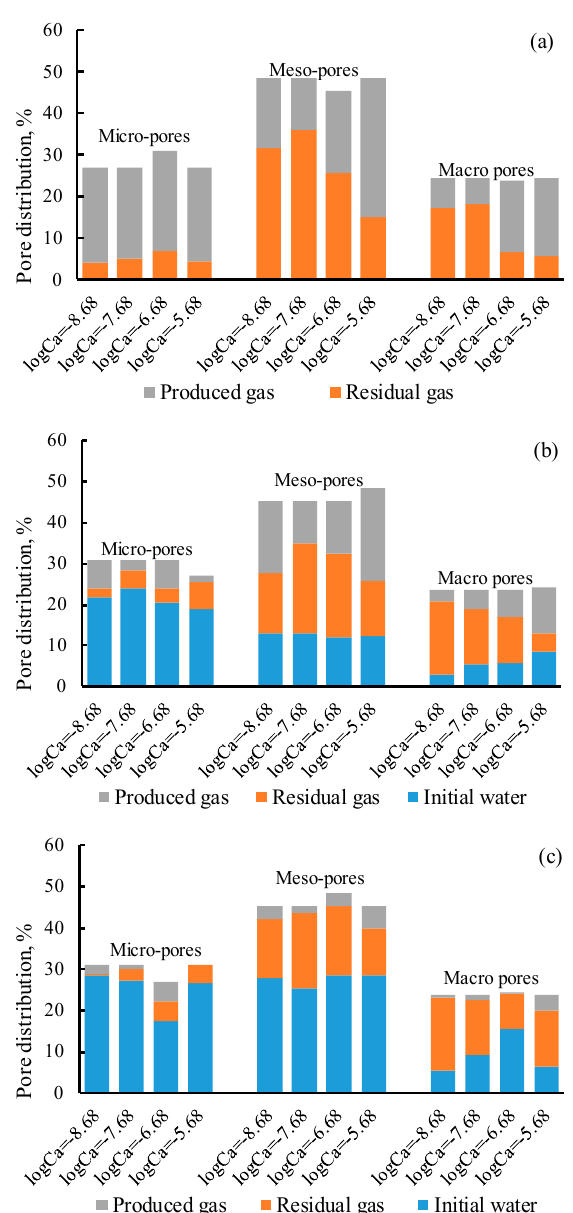
Figure 6. The pore distribution of initial water, residual gas and produced gas in micro-, meso- and macro- pores in forced imbibition experiments of samples #1-1F and #1-2F at different Ca and different S wi (the details of experiment samples are consistent with Figure 4): ( a ) S wi1 = 0; ( b ) S wi2 = 39.34 ± 1.57%; ( c ) S wi3 = 62.98 ± 2.22%.